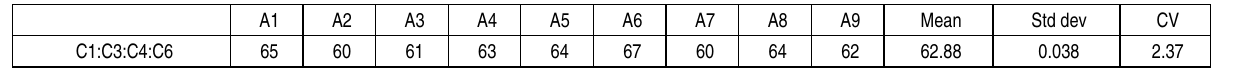
Table 49. Consortium C1:C4:C6 and C3